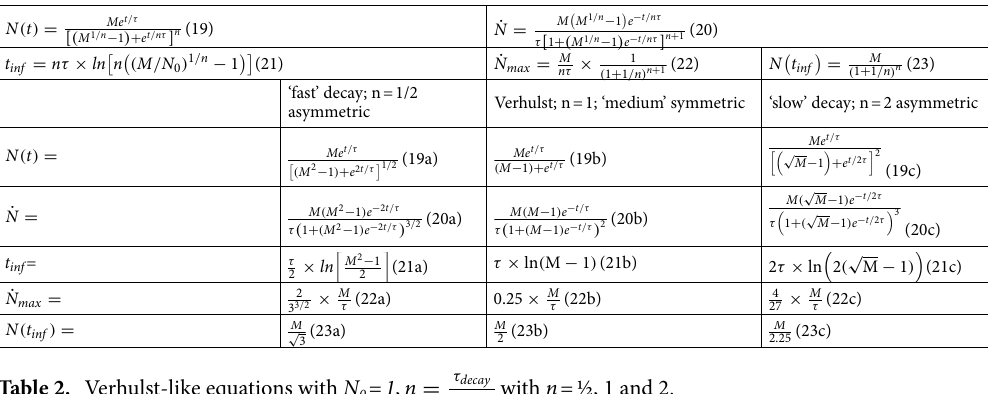
Table 2. Verhulst-like equations with N 0 = 1 , n =